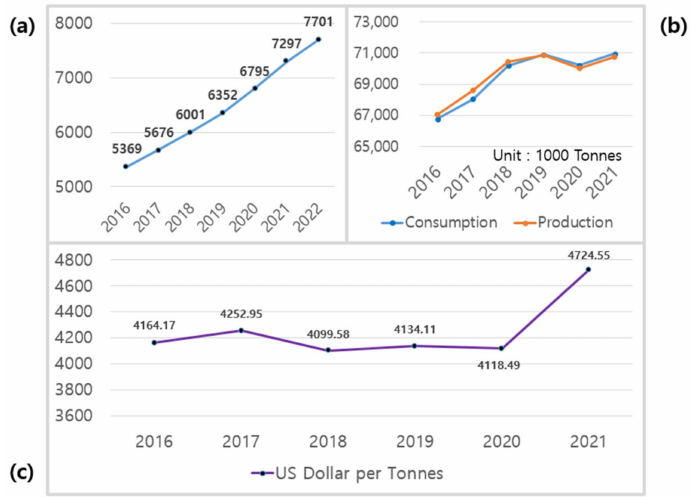
Figure 1. ( a ) Number of Korean beef farms producing more than a 100 head of cattle per year; ( b ) trends in world beef production and consumption; ( c ) trend of global beef prices. Some studies attempted to estimate the weight of animals using image-based